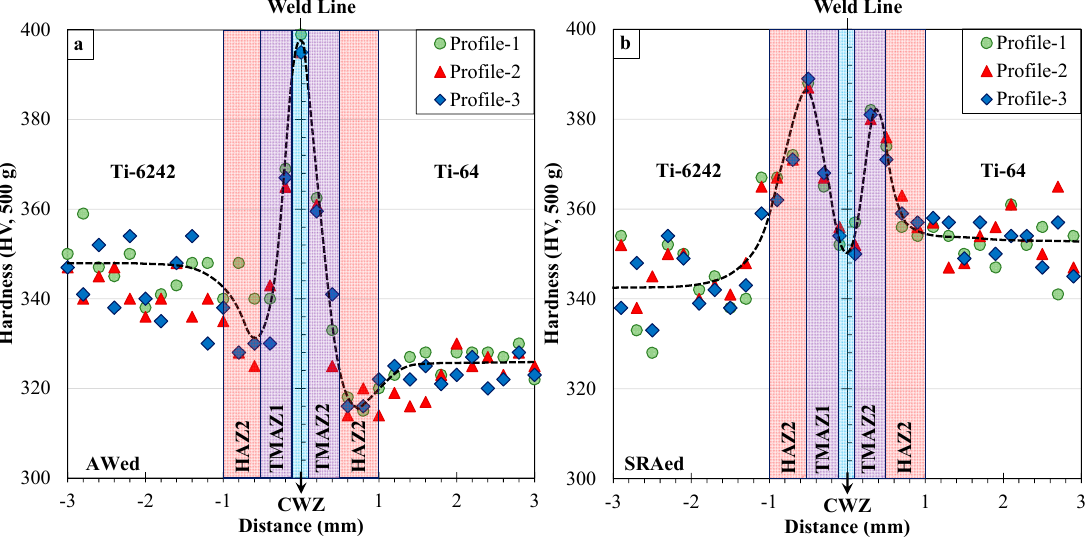
Figure 11. Microhardness profiles across the weld line in dissimilar linear friction welds between Ti-64 and Ti-6242 in ( a ) AWed and ( b ) SRAed conditions.